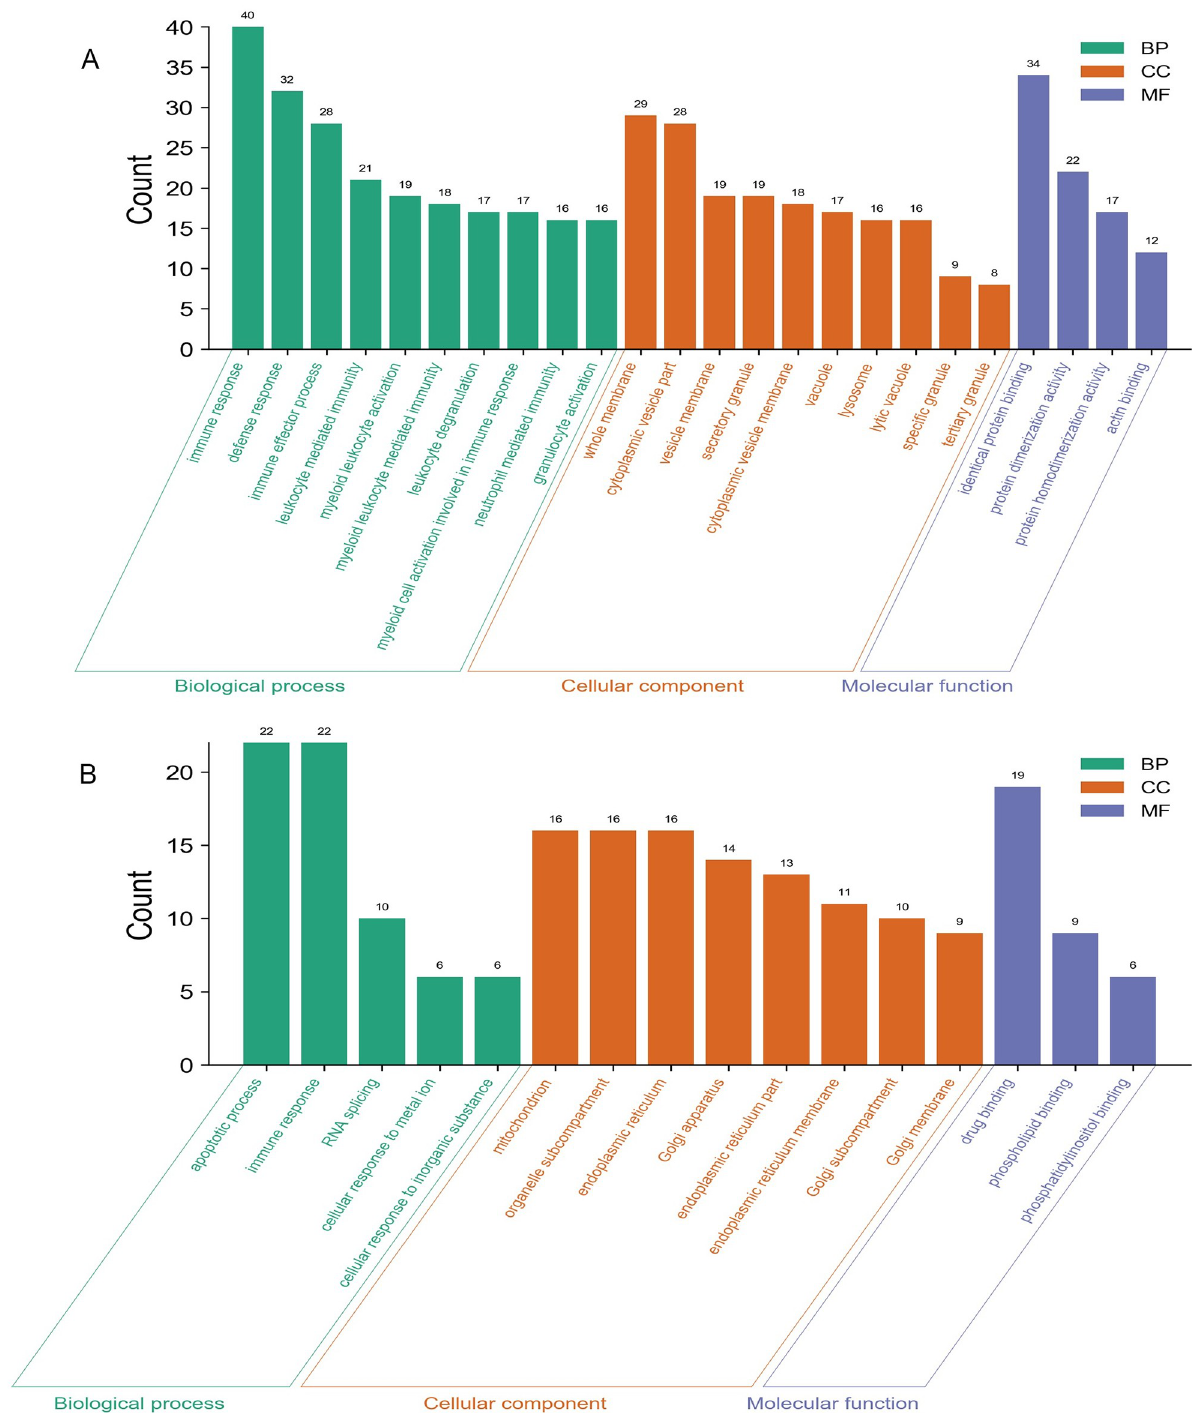
Fig 2. GO analyses of the male-specific upregulated (A) and downregulated (B). The y-axis depicts the number of genes. The x-axis lists the enriched functional terms. The color of bars corresponds to different categories of GO analysis (green represents BP, orange represents CC, and purple represents